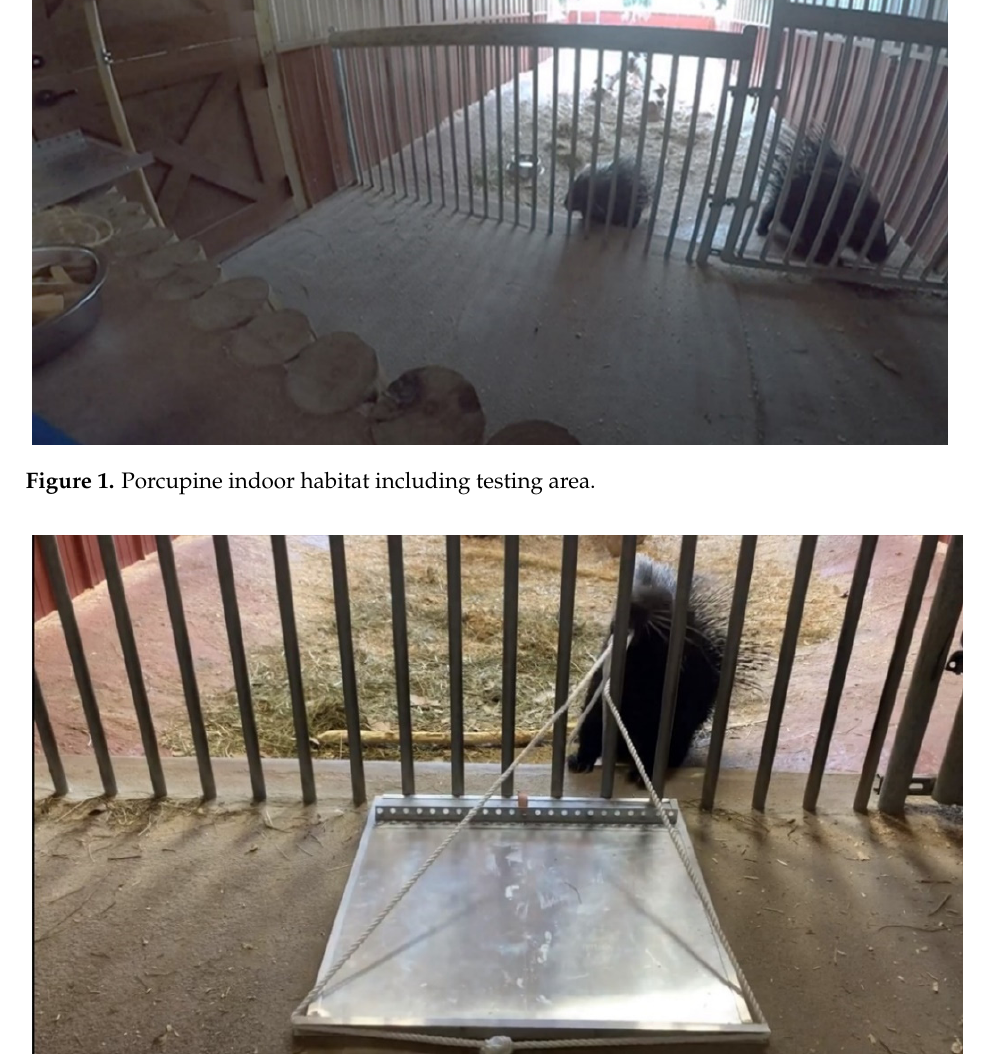
Figure 1. Porcupine indoor habitat including testing area.